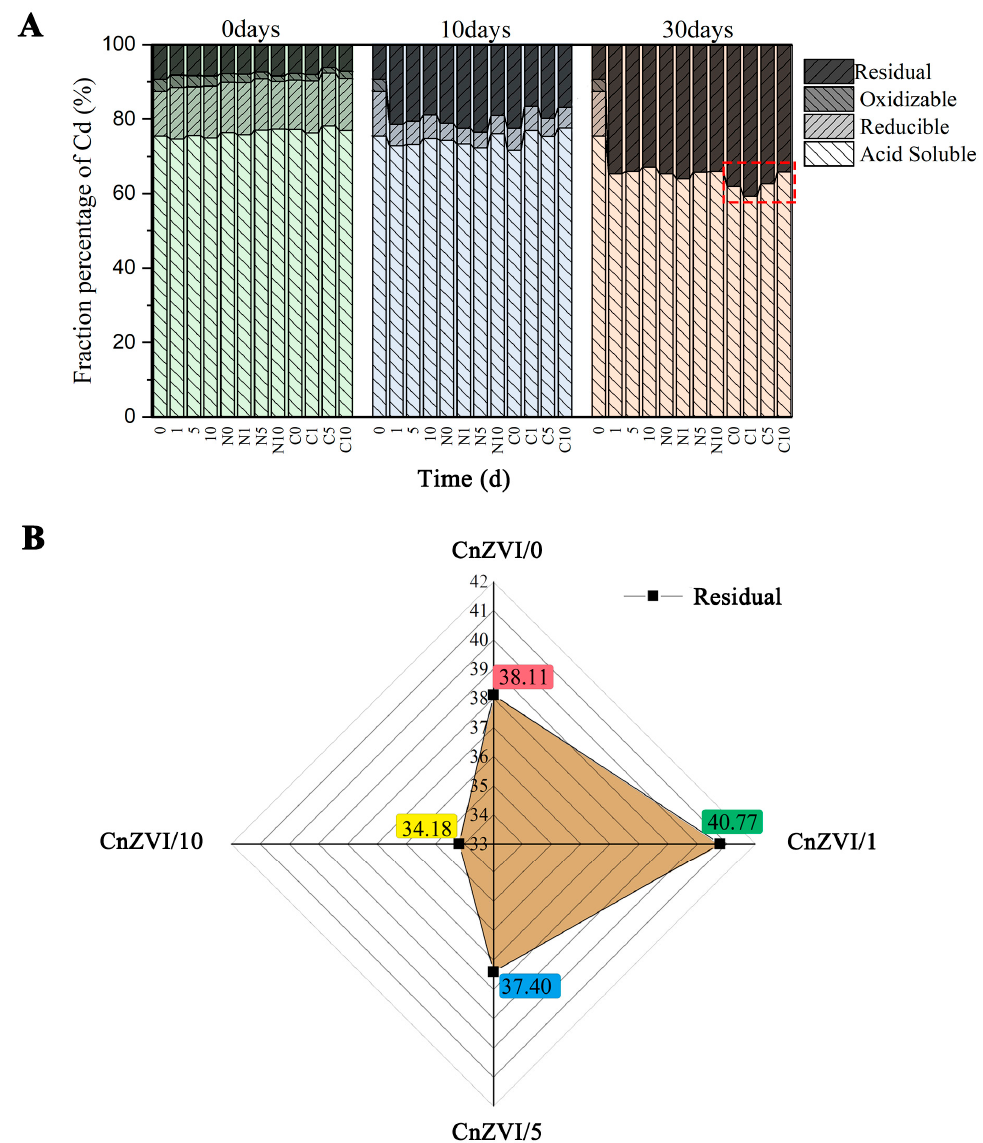
Figure 5. ( A ) The fractioning of Cd was tested as the incubation proceeded for 30 days. ( B ) The residual fraction percentage for four CnZVI groups after 30 days, where CnZVI/0 corresponds to CnZVI-6 with 0 mg/kg CA, CnZVI/1 corresponds to CnZVI-6 with 50 mg/kg CA, CnZVI/5 corresponds to CnZVI-6 with 250 mg/kg CA, and CnZVI/10 corresponds to CnZVI-6 with 500 mg/kg CA.